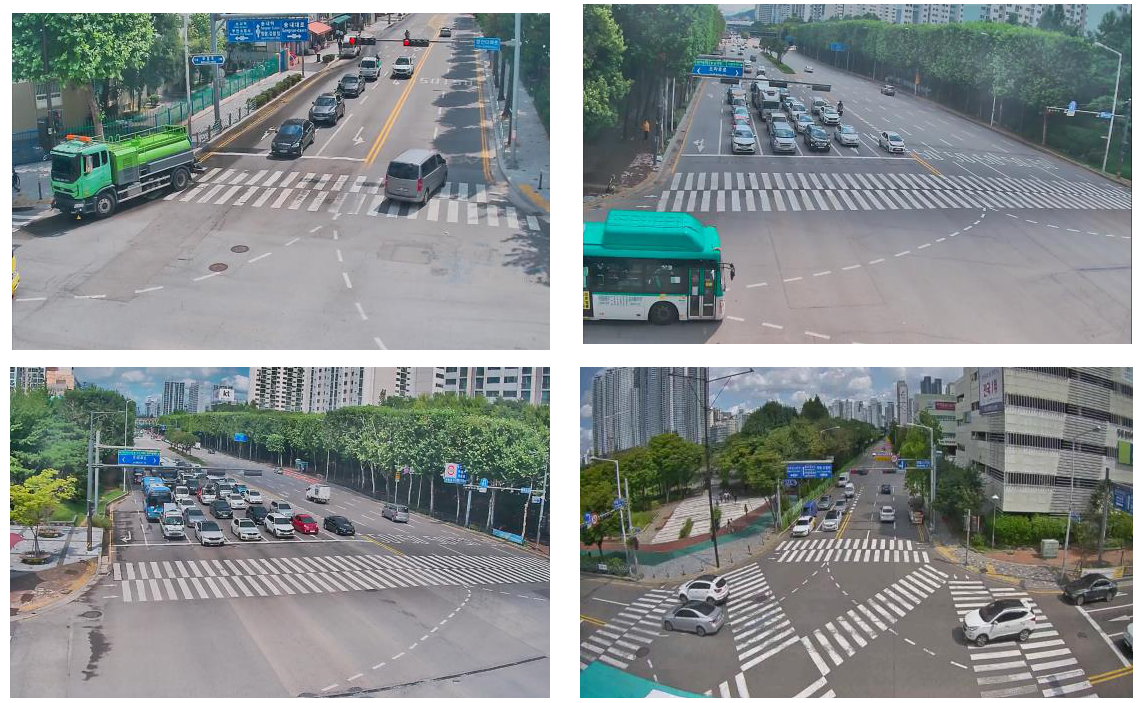
Figure 1. Example images of multiple traffic surveillance cameras.